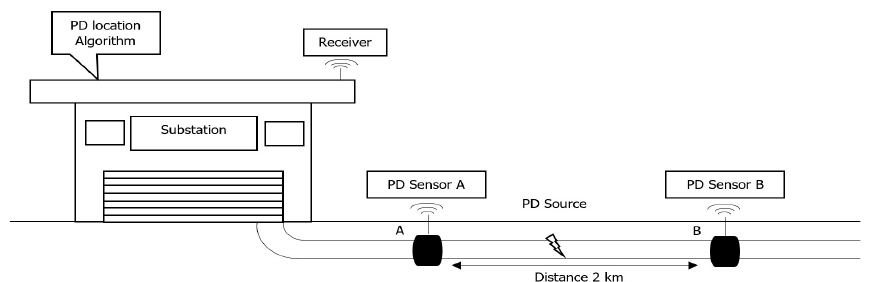
Figure 2. Diagram of the online PD localization estimation system for underground cables.